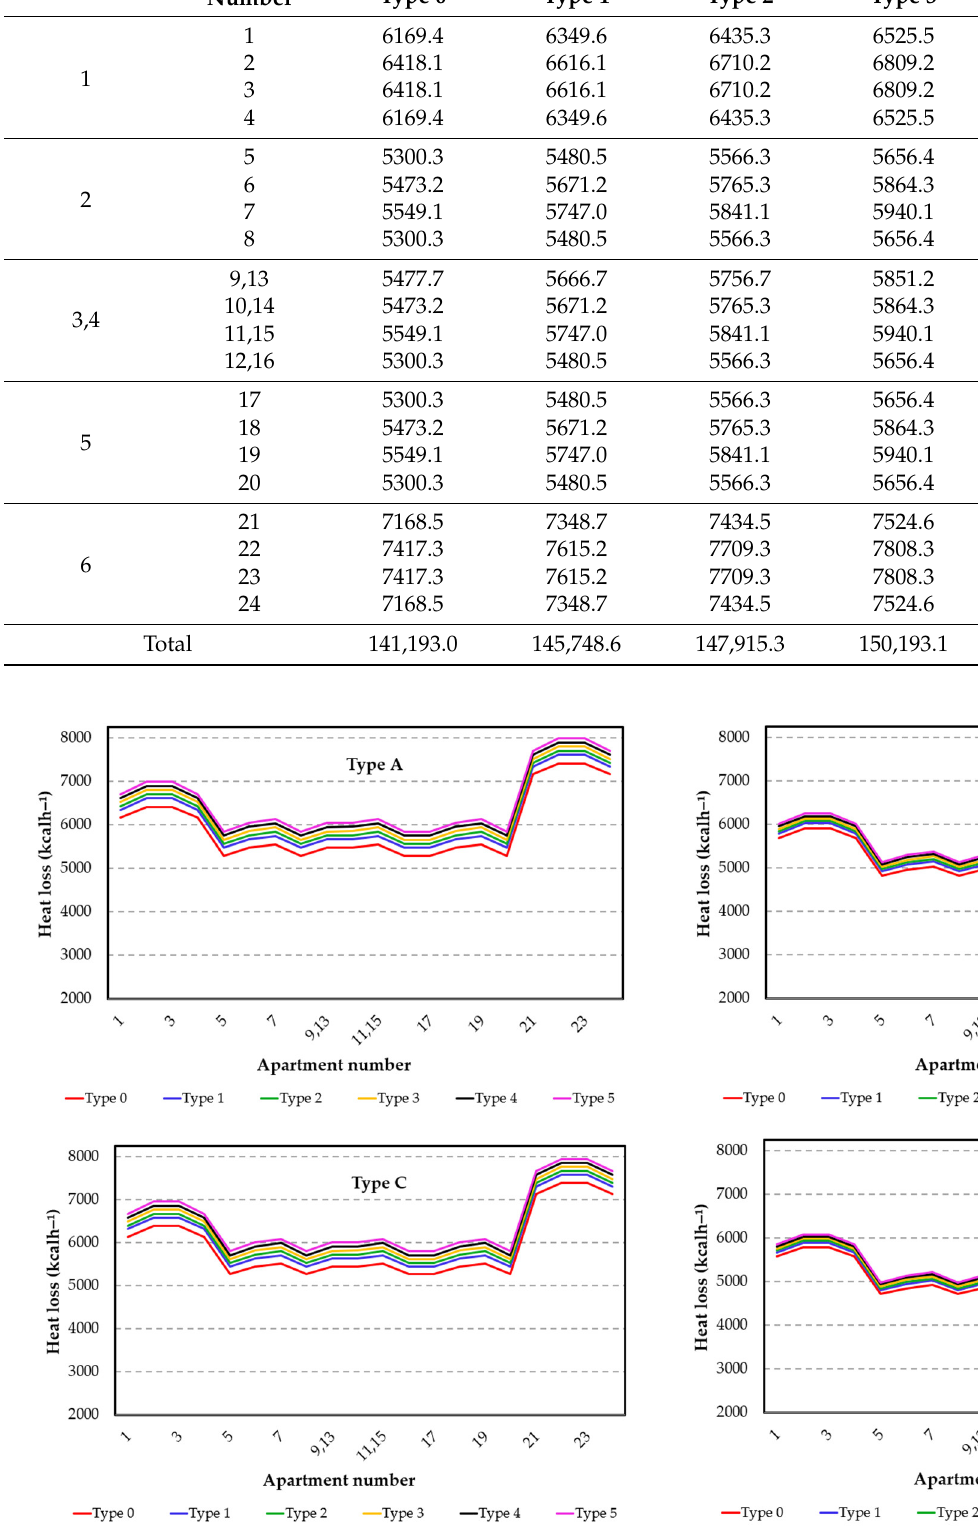
Figure 4. Comparison of heat loss according to window type for